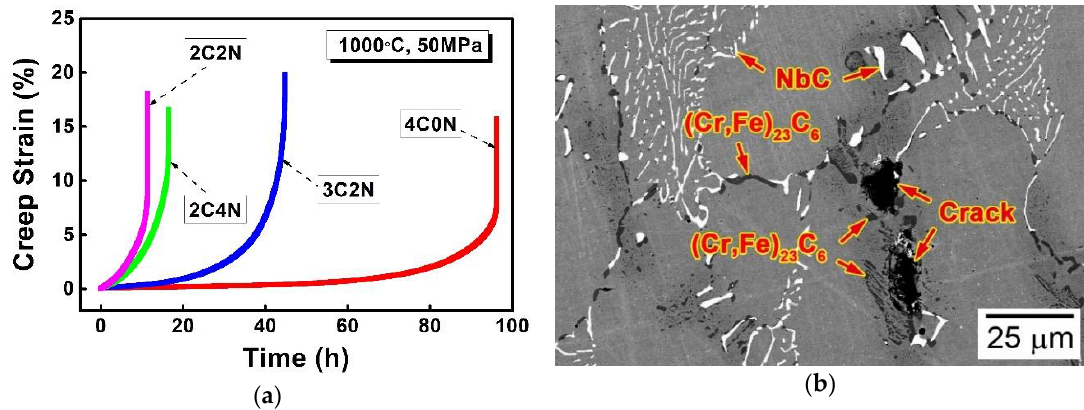
Figure 10. ( a ) Creep strain-time curves of the as-cast alloys tested at 1000 °C and 50 MPa; ( b ) SEM-BSE image showing the typical creep cracks in alloy 4C0N after creep ruptured.